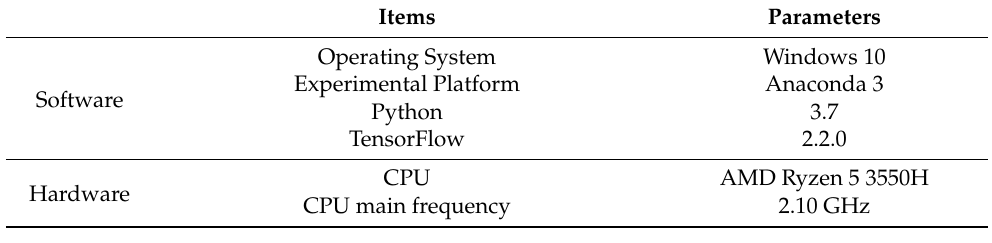
Table 3. Software and hardware environment experiment parameters.